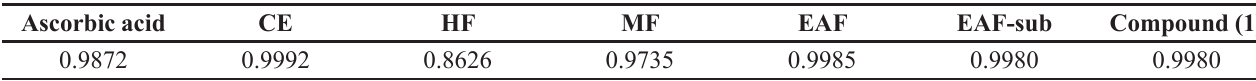
TABLE I - Correlation coefficient (R 2 ) of DPPH assay Ascorbic acid